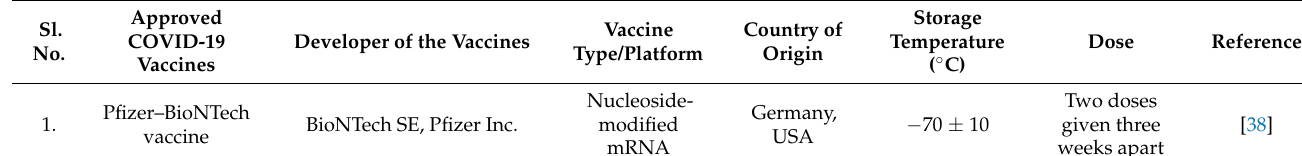
Table 1. Different approved COVID-19